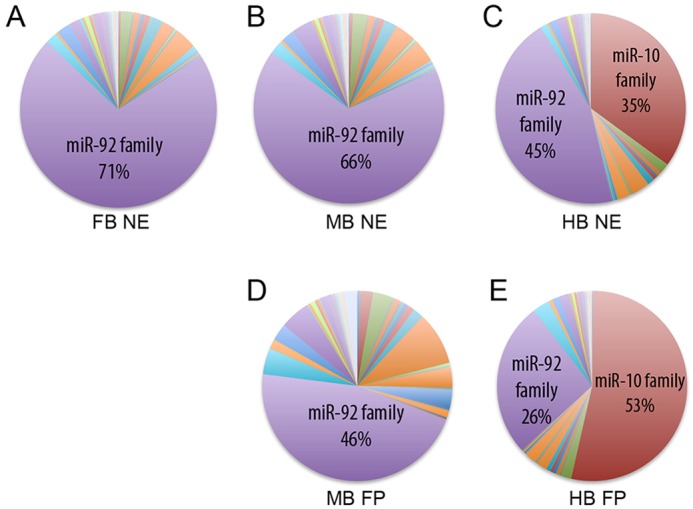
Expression of miRNA families in human NE and FP cells. (A-C) Circular charts demonstrating miRNA expression grouped into families. The miR-92 family constitutes a large proportion of all miRNA families expressed in NE cells patterned towards FB, MB and HB. In the HB NE cells, the miR-10-family represents 35% of all miRNAs, while it is absent from the FB and MB NE cells. (D,E) The proportion of miR-92 family expression is also high in FP cells from both MB and HB. Expression of the miR-10 family constitutes more than half of all miRNAs in the FP cells of the HB.